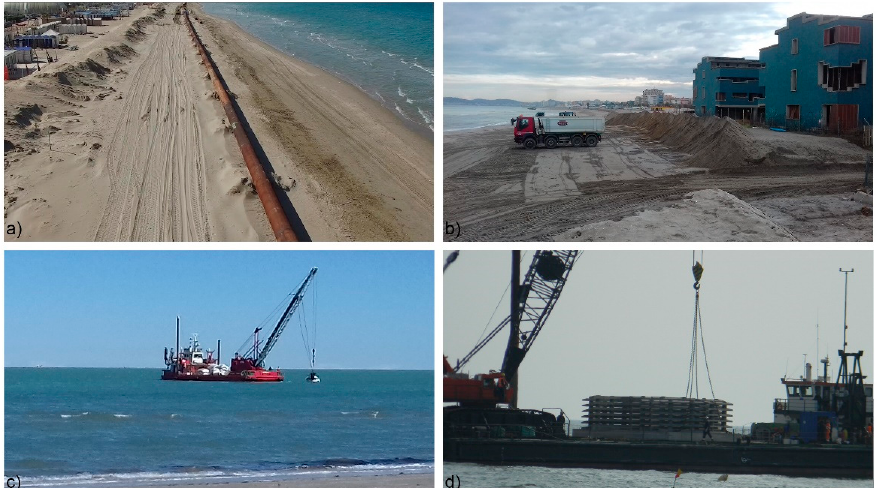
Figure 2. Interventions carried out on the emerged and submerged beach of Riccione: ( a ) replenish- ment operations in 2016; ( b ) creation of the artificial embankment in the backshore in winter; ( c ) periodical recharge of the sandbag barrier; ( d ) W-Mesh modules to be settled down on the seabed. Moreover, as common practice before the winter season, large volumes of sediments are moved with trucks and excavators from the berm/intertidal zone (foreshore) toward the landward part of the beach. Here, an embankment some meters high is created, pro- tecting the beach and the backshore from winter storms (Figure 2b). Before the